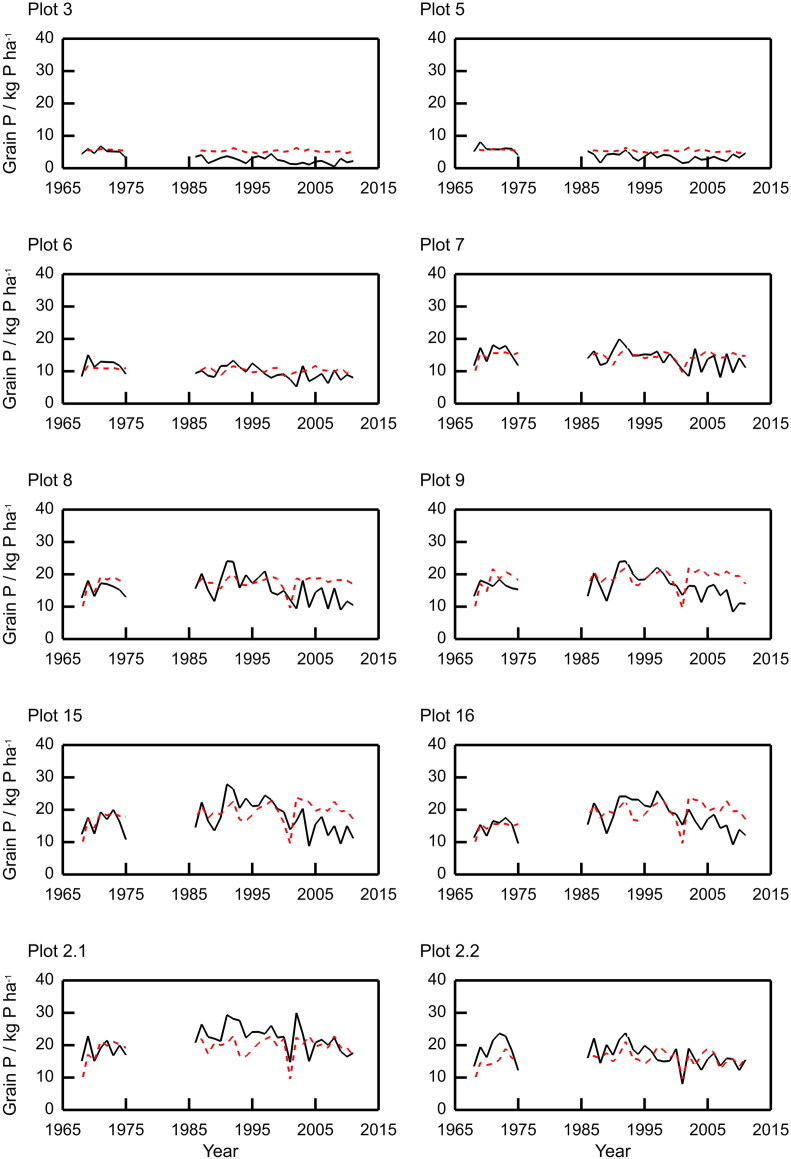
Measured (black lines) and modelled (red dashed lines) grain P content for ten plots from the Broadbalk long-term wheat experiment (1968–1975 and 1986–2011), continuous wheat. The measured values were from Section 1 only (see 2.9.1).